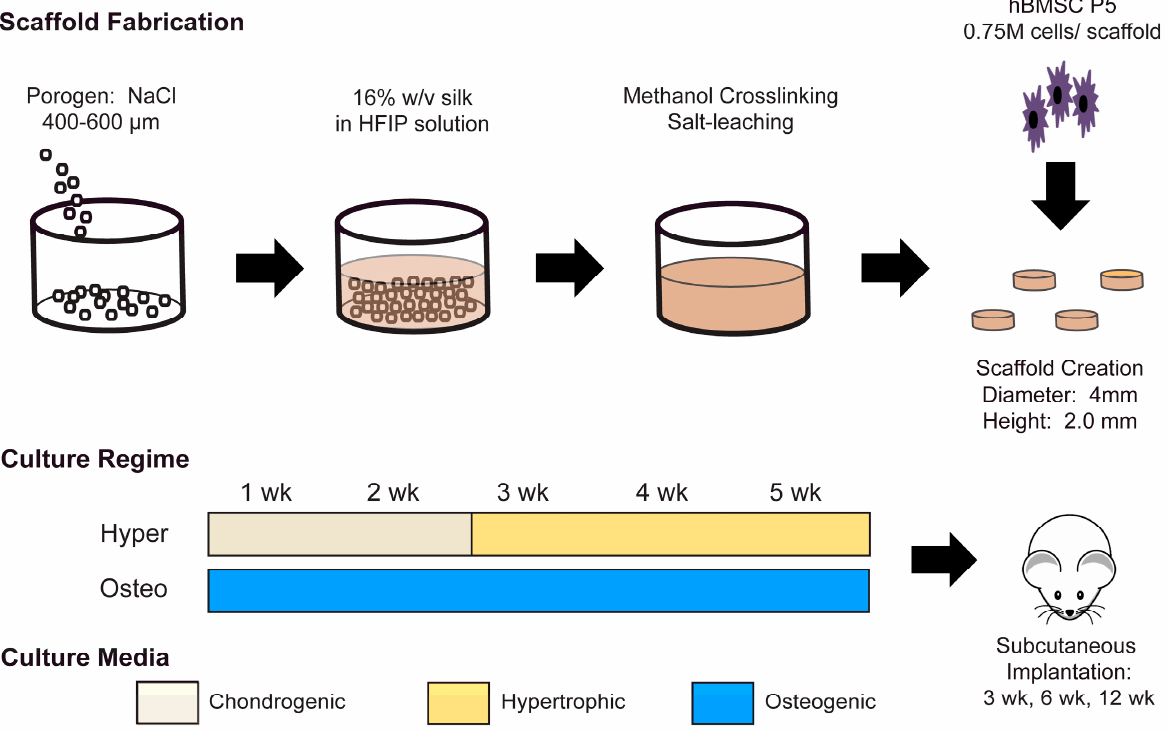
Figure 1. Experimental design. Porous cylindrical scaffolds (4 mm in diameter × 2 mm high) were made from a silk fibroin solution using the HFIP-based salt-leaching technique, and seeded with human bone marrow MSCs from a consistent pool. The MSCs were differentiated in parallel into two ossification pathways. Hypertrophic chondrocyte constructs (Hyper) were derived from MSCs by cultivation in a chondrogenic medium for 2 weeks and then matured to hypertrophic chondro- cytes over 3 weeks in a hypertrophic medium to mimic endochondral ossification. Osteoblast con- structs (Osteo) were cultured for 5 weeks in an osteogenic medium to generate osteoblasts and mimic intramembranous ossification. After in vitro cultivation, scaffolds from each ossification pathway were implanted subcutaneously in nude mice and harvested for analysis at 3 weeks, 6 weeks, and 12 weeks after implantation.